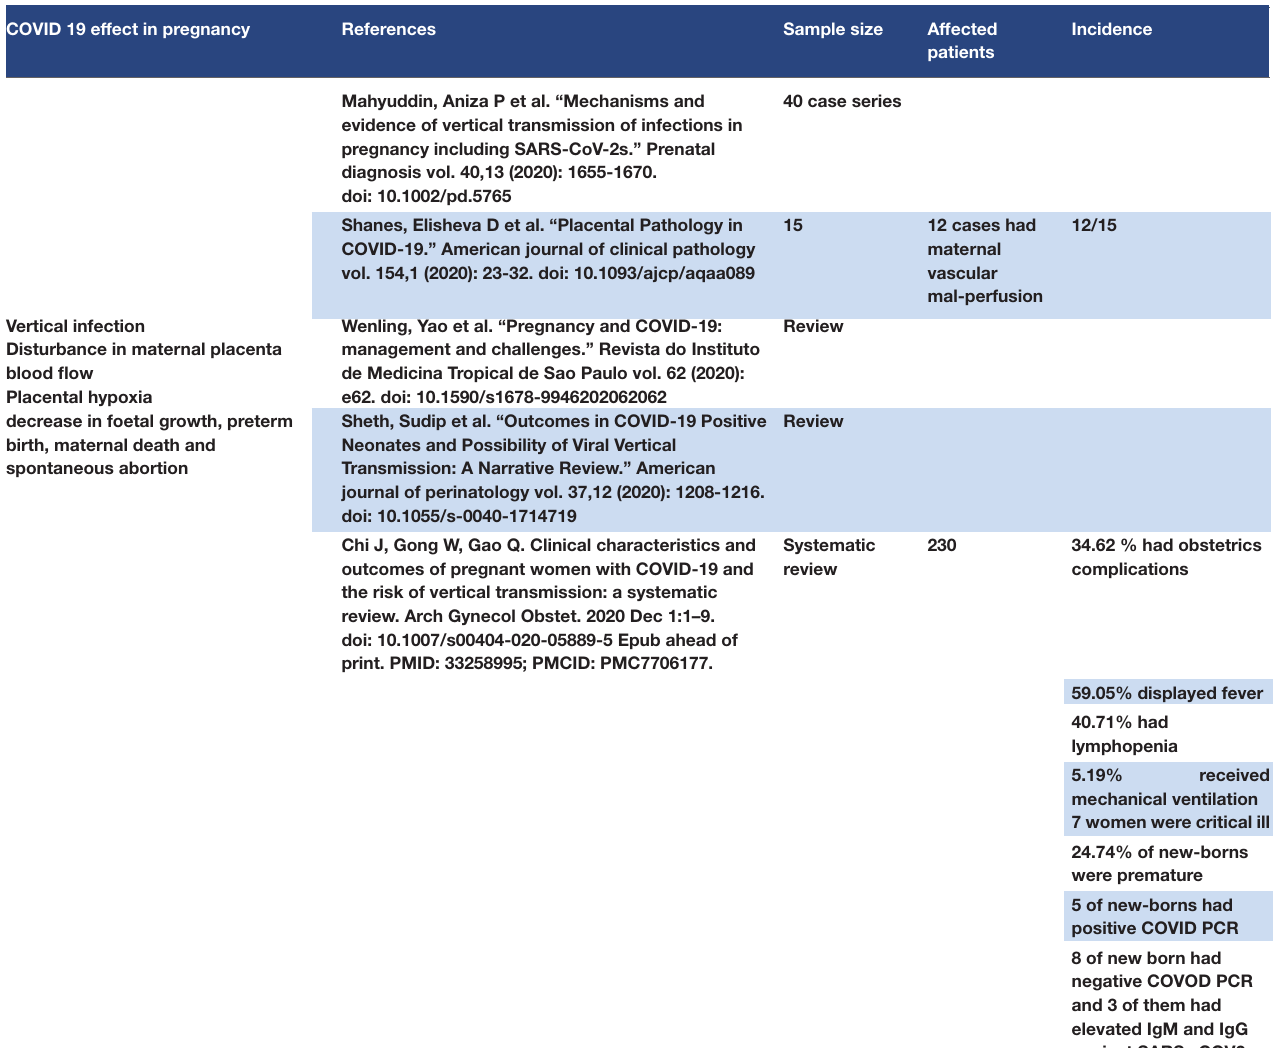
TABLE 11 | COVID 19 effect in